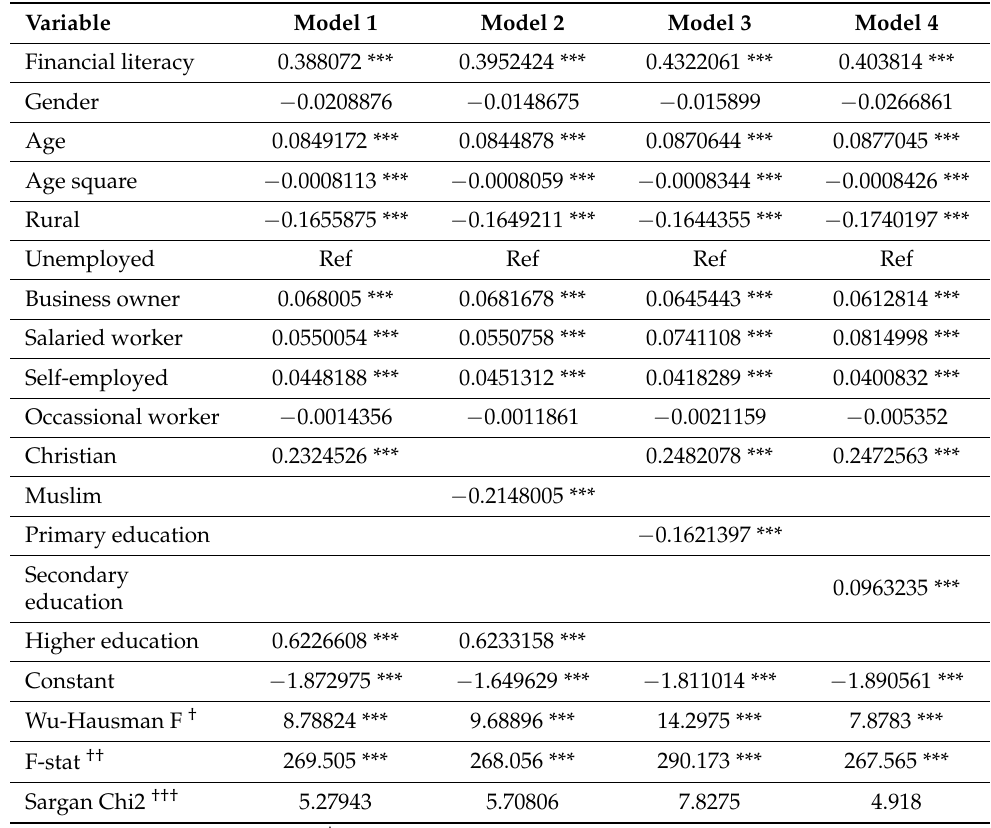
Table 4. Financial literacy and financial inclusion in Kenya: IV regression